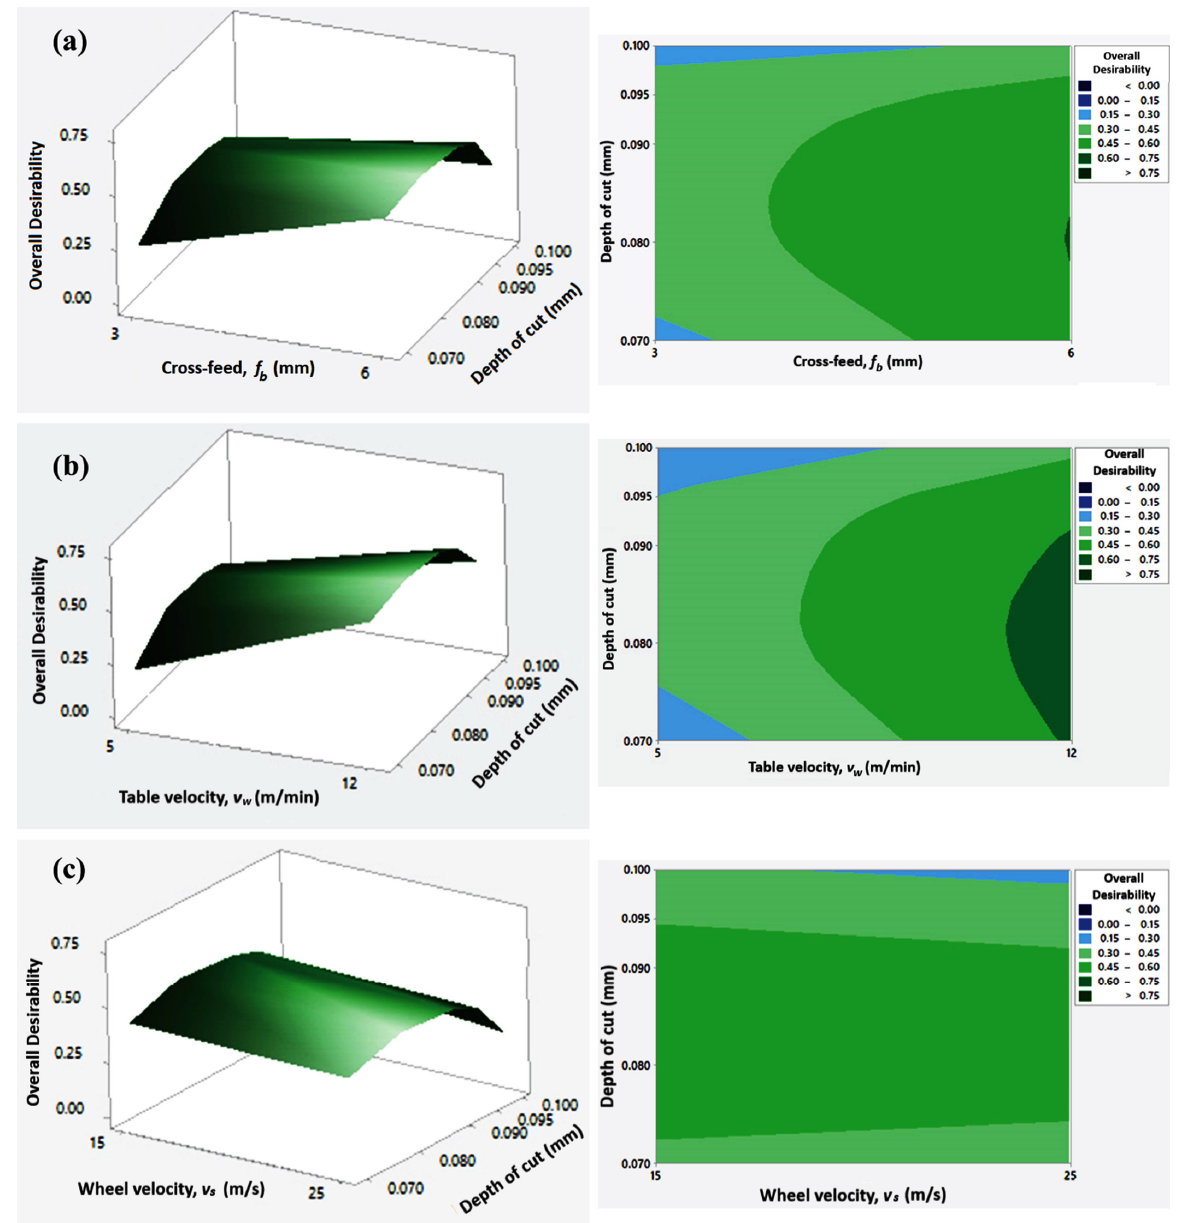
Figure 9. Surface plot and corresponding contour plot for overall desirability in dry condition. ( a ) show the combined effect of cross-feed and depth of cut, ( b ) table velocity and depth of cut and ( c ) wheel velocity and depth of cut on overall desirability.